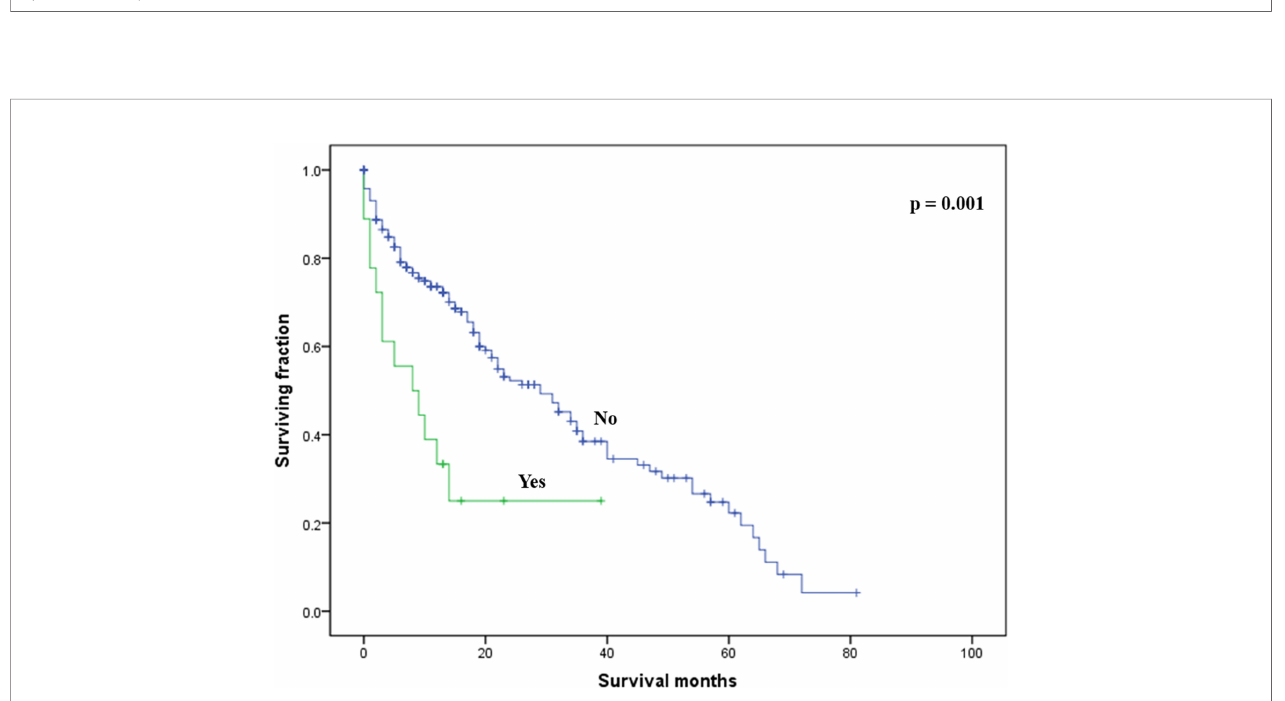
FIGURE 5 | Kaplan – Meier method-estimated OS male breast cancer with bone metastasis strati fi ed by brain metastasis. (OS, overall